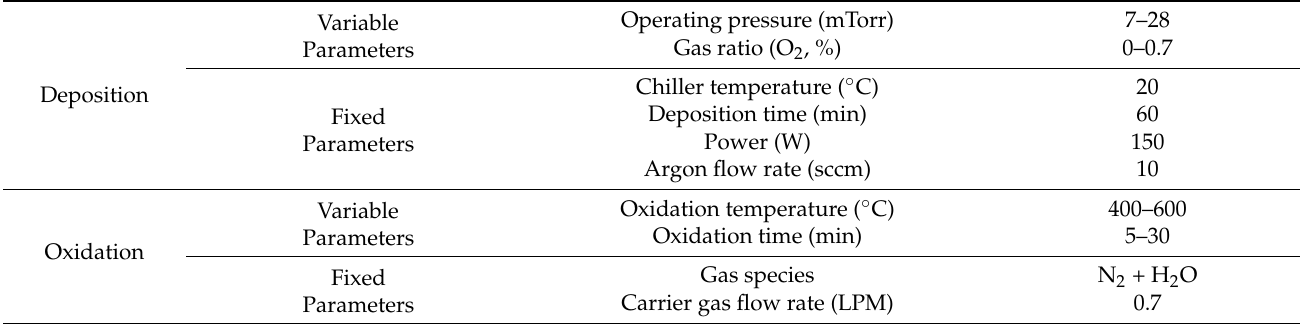
Figure 1. Schematic diagram of the modified DC magnetron sputtering system used in this study [34]. Table 1. Summary of the experimental parameters used in this study for fabrication of the porous zinc oxide thin films.